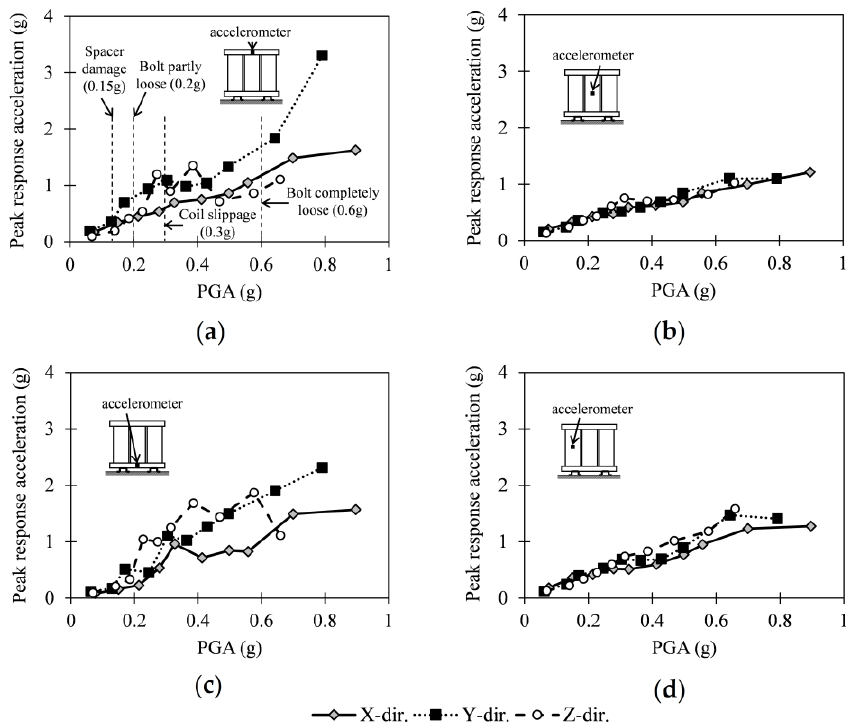
Figure 14. Peak acceleration response versus PGA at different locations of accelerometers. ( a ) At top beam; ( b ) At center coil; ( c ) At bottom beam; ( d ) At left coil.